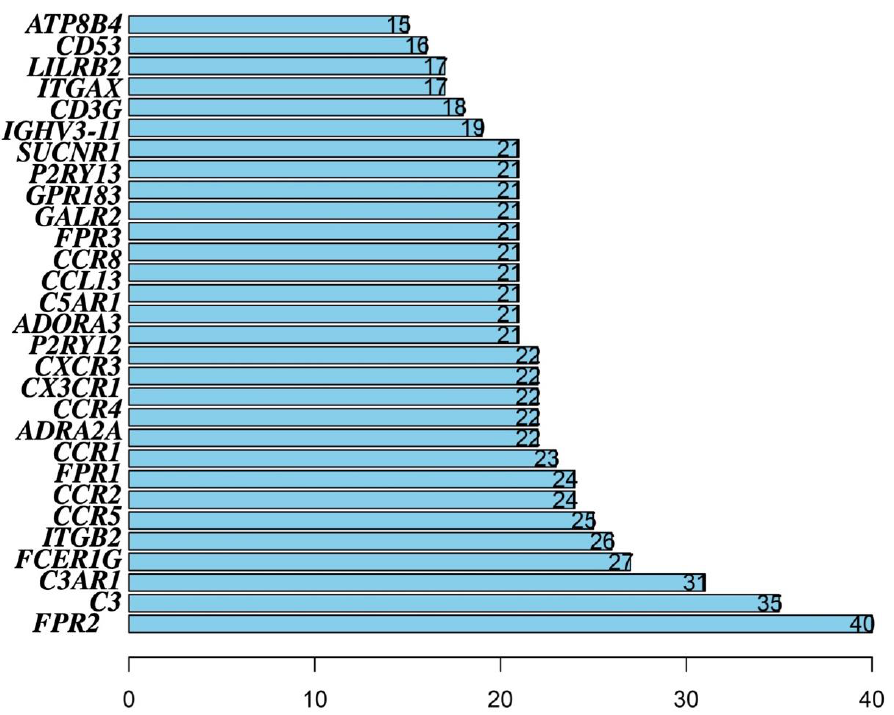
Figure 6. The top 30 key genes analyzed by PPI which associated with the prognosis of OSCC patients, including ATP8B4 , CD53 , LILRB2 , ITGAX , CD3G , IGHV3-11 , SUCNR1 , P2RY13 , GPR183 , GALR2 , FPR3 , CCR8 , CCL13 , C5AR1 , ADORA3 , P2RY12 , CXCR3 , CX3CR1 , CCR4 , ADRA2A , CCR1 , FPR1 , CCR2 , CCR5 , ITGB2 , FCER1G , C3AR1 , C3 and FPR2 .